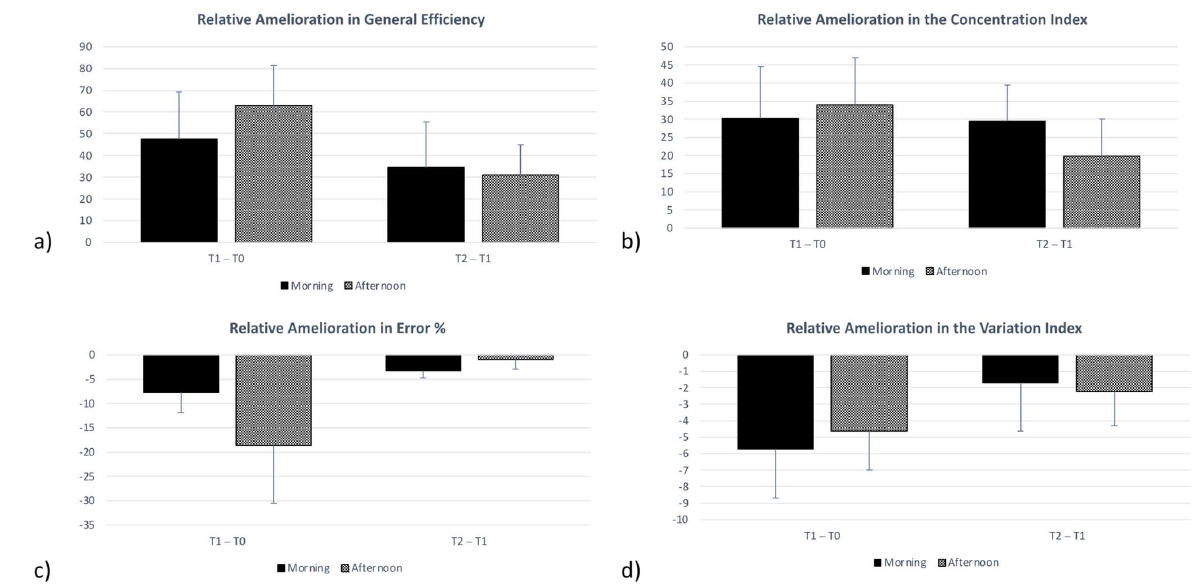
Figure 6 showcases the absence of differences between the M and A groups across the different time points (from T0 to T1 and from T1 to T2).